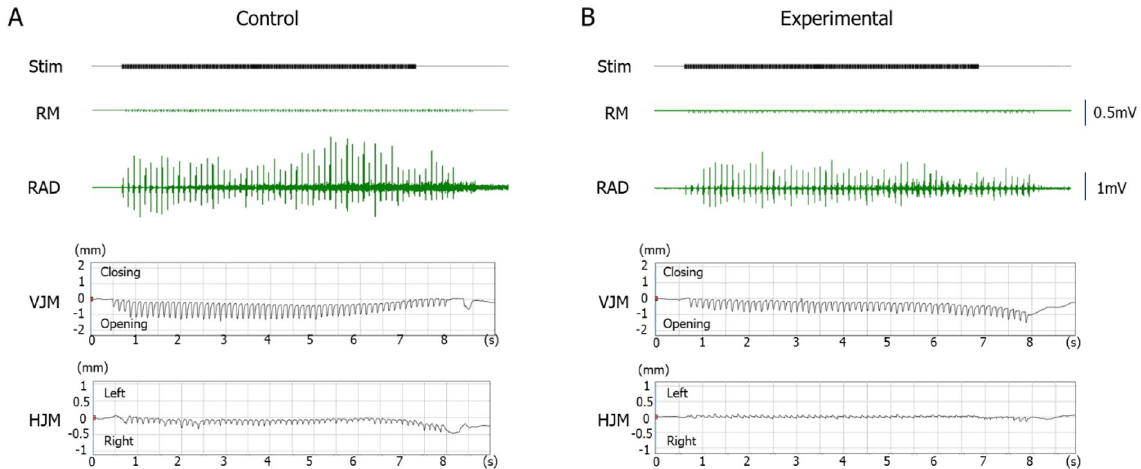
Figure 1. Typical example of electromyographic activity with jaw movement patterns elicited by electrical stimulation of the anterior part of the cortical masticatory area. Control ( A ) and experimental ( B ) groups at 11 weeks of age are shown. Stim electrical stimulation, RM right masseter muscle, RAD right anterior digastric muscle, VJM vertical jaw movements, HJM horizontal jaw